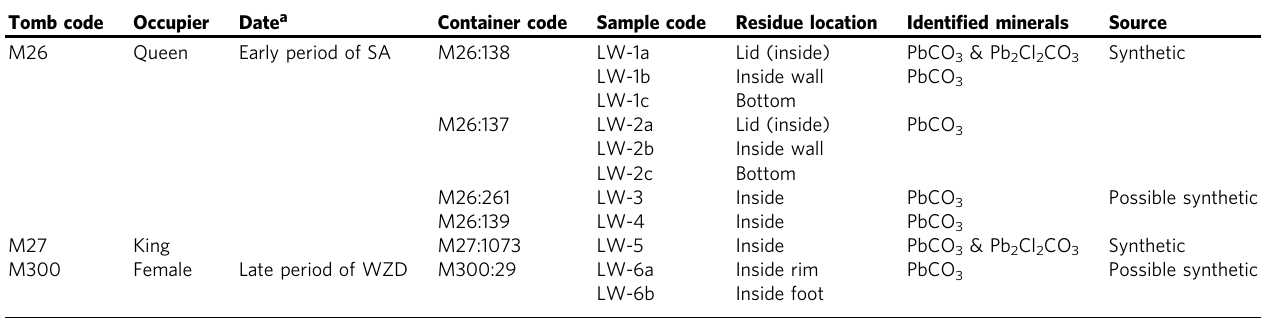
Table 1 White residues in miniature bronze containers from the Liangdaicun